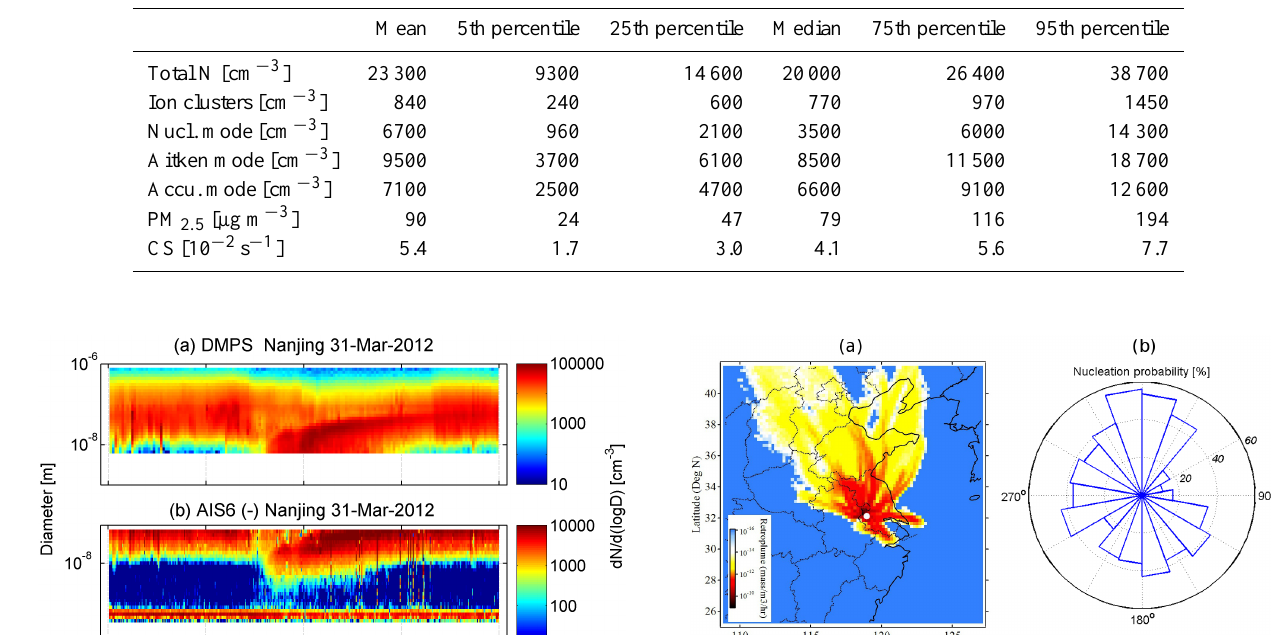
Table 2. Aerosol population statistics.